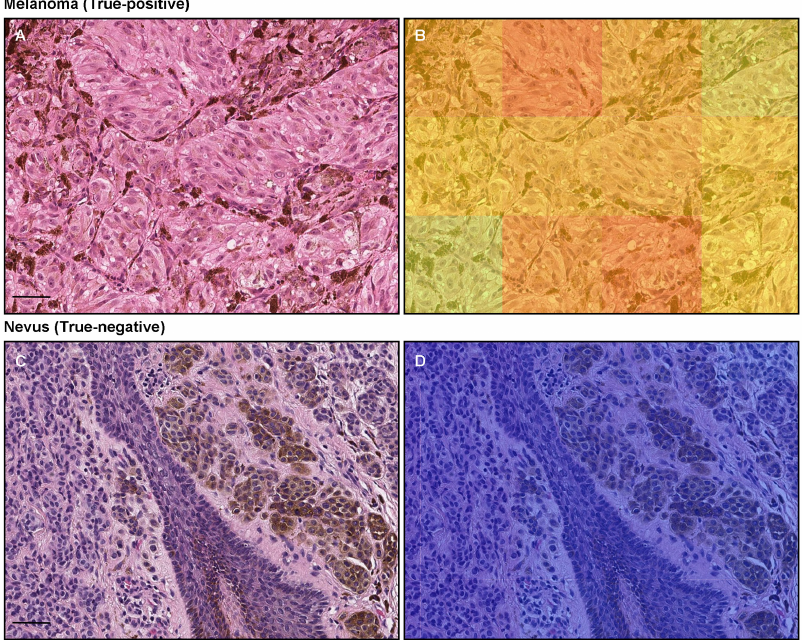
Figure 4. An example of true positive and true negative predictions of melanoma using the × 20, 512 × 512 px model. ( A ) was a melanoma area with melanin, which was true-positively predicted as melanoma by the heatmap image ( B ). ( C ) was a melanocytic nevus area with and without melanin, which was true-negatively predicted as melanoma by the heatmap image ( D ). Red indicates a high probability and blue indicates a low probability. Scale bars: 50 µ